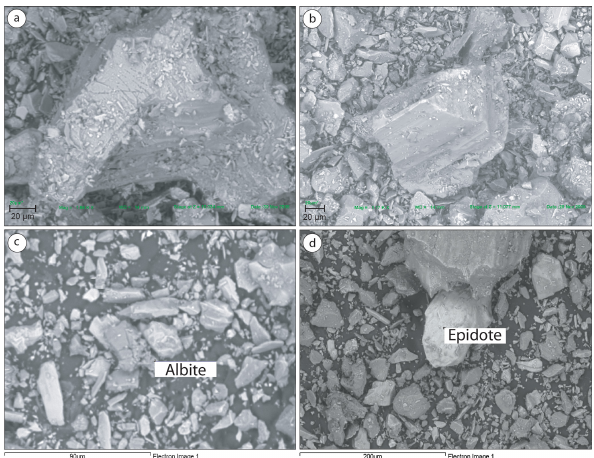
Figure 6. SEM images indicating only slight chemical weathering of fine matrix. (a) Albite, with a chemically etched surface; the only etched grain identified (BG-05-84, Tarfalatjårro pit 7). (b) Chem- ically unaltered amphibole, typical of all SEM images of amphi- bole (BG-05-26, Alddasˇcorru pit 2). (c) Disintegrating albite, pos- sibly through chemical processes (BG-05-11, Alddasˇcorru pit 1). (d) Chemically unaltered epidote, typical of all SEM images of epi- dote (BG-05-04, Alddasˇcorru pit 1).